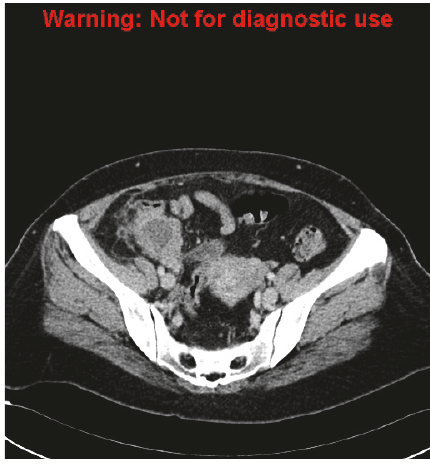
Figure 4: Repeat CT scan demonstrates a largely stable periappen- diceal collection.